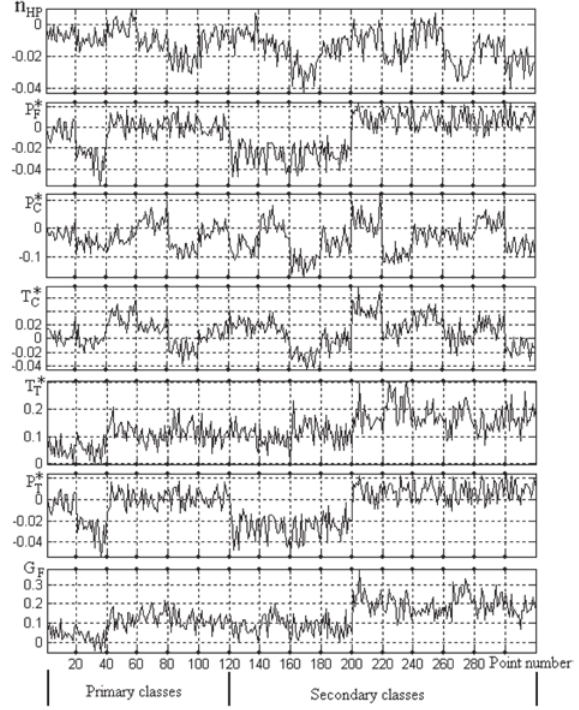
Fig. 1. The values of diagnostic deviation (Eq. (1)) in the